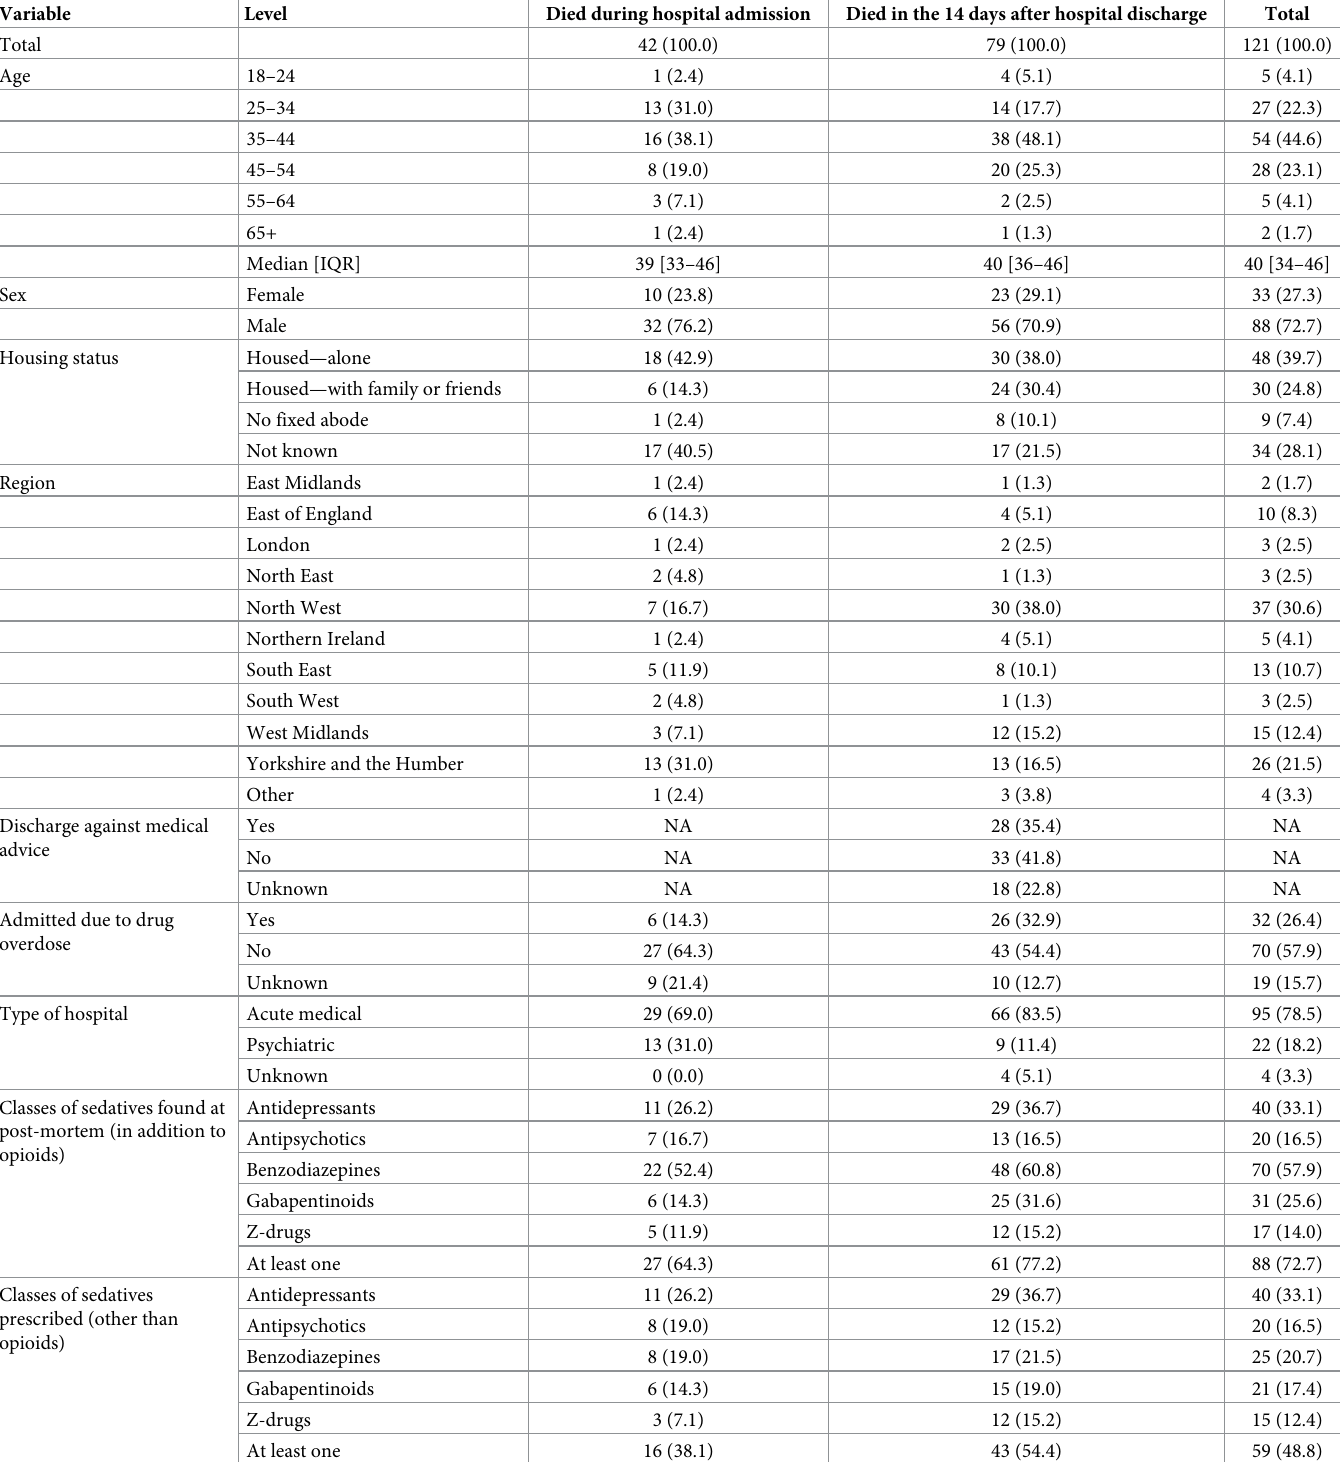
Table 1. Characteristics of study participants; data from NPSAD